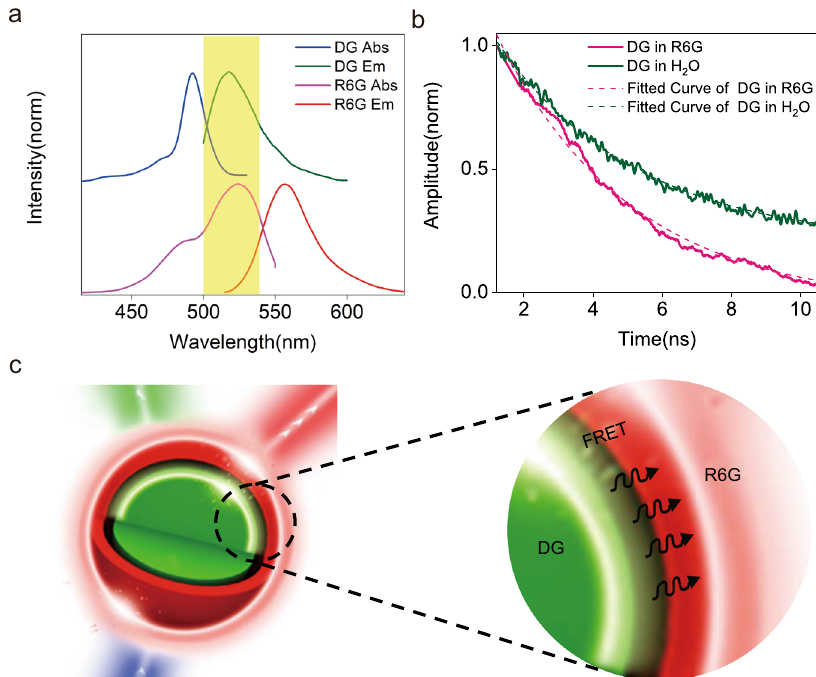
Fig.2|FRETdeterminesR6Glasing.a AbsorptionandemissionspectraofDGand R6G showa strong overlapof DGemissionand R6G absorption spectra, indicating good energy conservation. b Time-resolved fl uorescence decay of DG in the